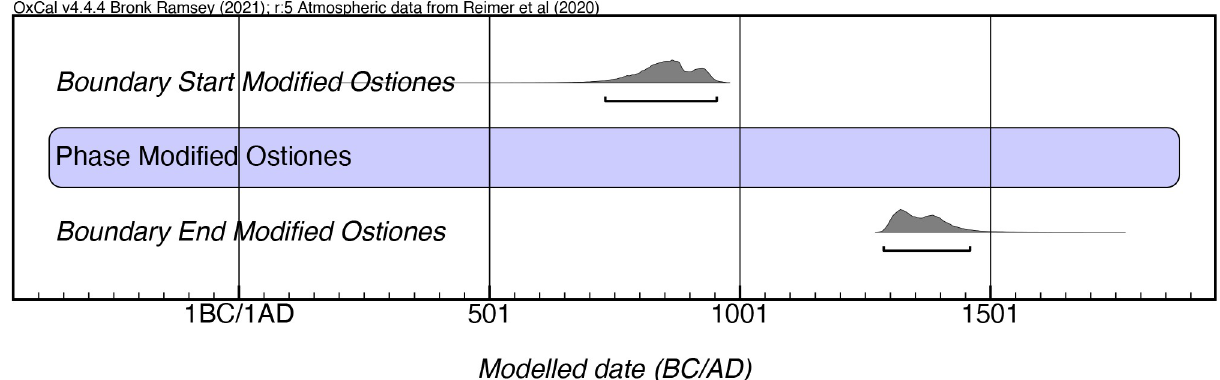
Fig 12. Modeled date ranges for the Modified Ostiones manifestation in Puerto Rico. Probability distributions indicate modeled 2 σ (95.4%) confidence intervals for beginning and end of phase.